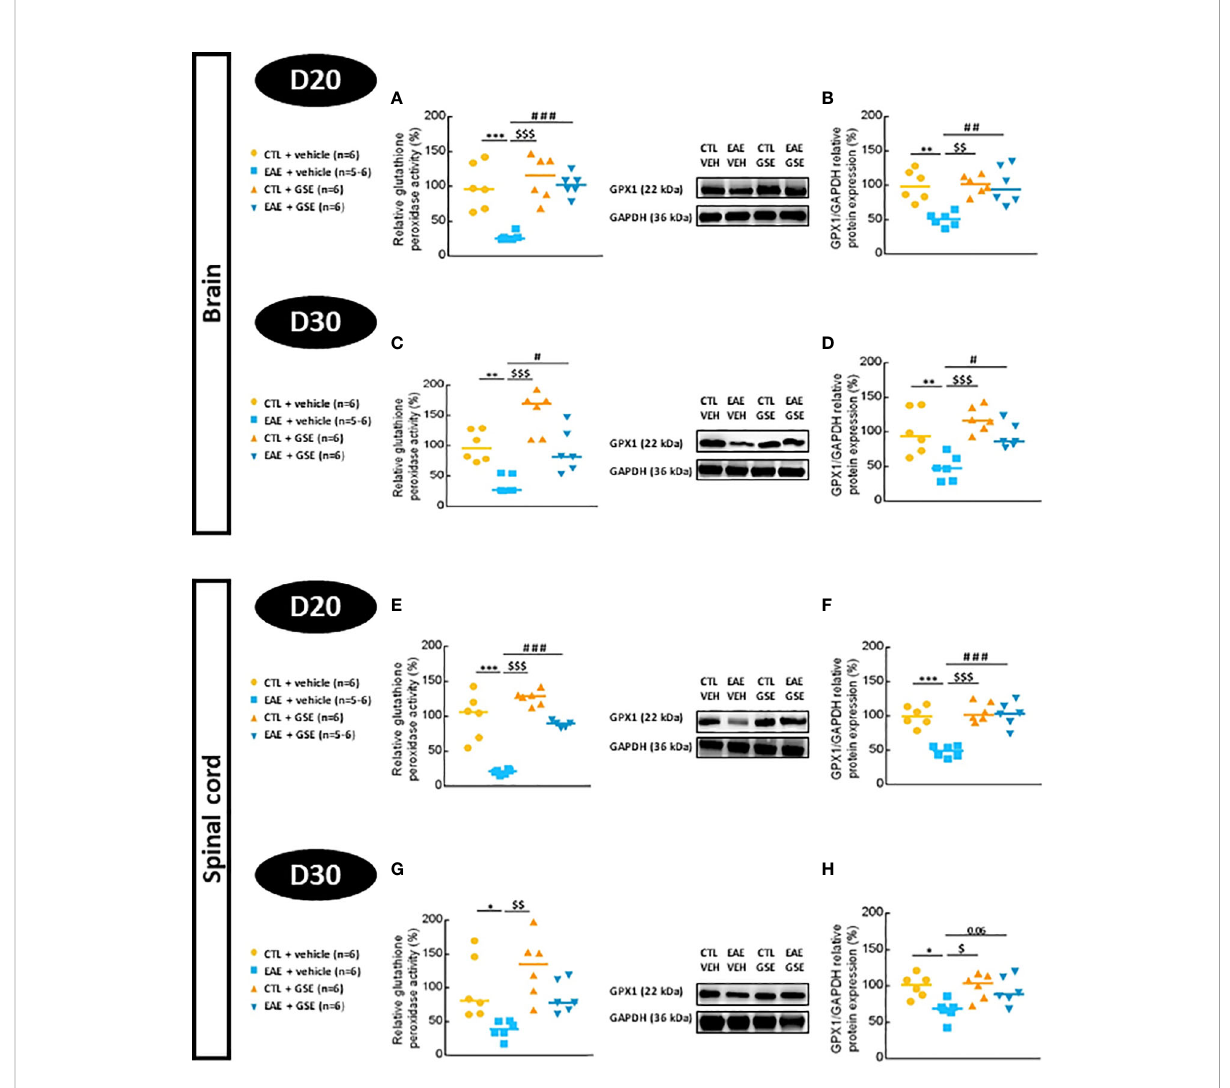
FIGURE 6 Evaluation of glutathione peroxidase activity and protein expression in the brain and spinal cord of experimental autoimmune encephalomyelitis mice (EAE) and their controls (CTL) after curative treatment with grape seed extract (GSE) or vehicle. Glutathione peroxidase activity was expressed as the relative activity (%) compared to CTL + vehicle group, in the brain (A, C) and the spinal cord (E, G) at D20 (A, E) or D30 (C, G) post-induction. GPX1/GAPDH protein expression was expressed as the relative protein expression (%) compared to CTL + vehicle group, in the brain (B, D) and the spinal cord (F, H) at D20 (B, F) or D30 (D, H) post-induction. For each protein level quanti fi cation, a representative Western blotting image of the target protein and loading control is proposed. Statistical analysis was performed using one-way ANOVA followed by Tukey ’ s multiple comparison test: *p < 0.05, **p < 0.01, ***p < 0.001 EAE + vehicle vs CTL + vehicle; #p < 0.05, ##p < 0.01, ###p < 0.001 EAE + GSE vs EAE + vehicle and $p < 0.05, $$p < 0.01, $$$<0.001 EAE + vehicle vs CTL +